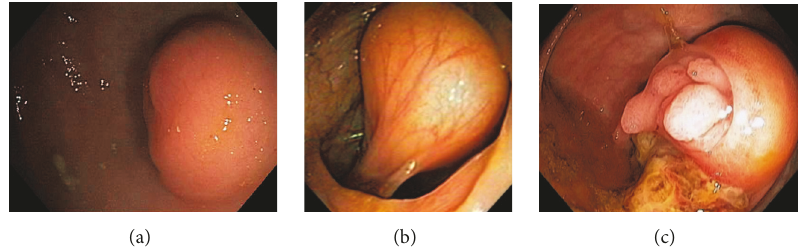
Figure 39: Endoscopic images of appendiceal mucoceles. The first mucocele is caused by a retention cyst or mucosal hyperplasia (a). The second mucocele is caused by a mucinous cystadenoma (b). A mucinous adenocarcinoma is responsible for the third mucocele (c). A large amount of mucin is present in the cecum.